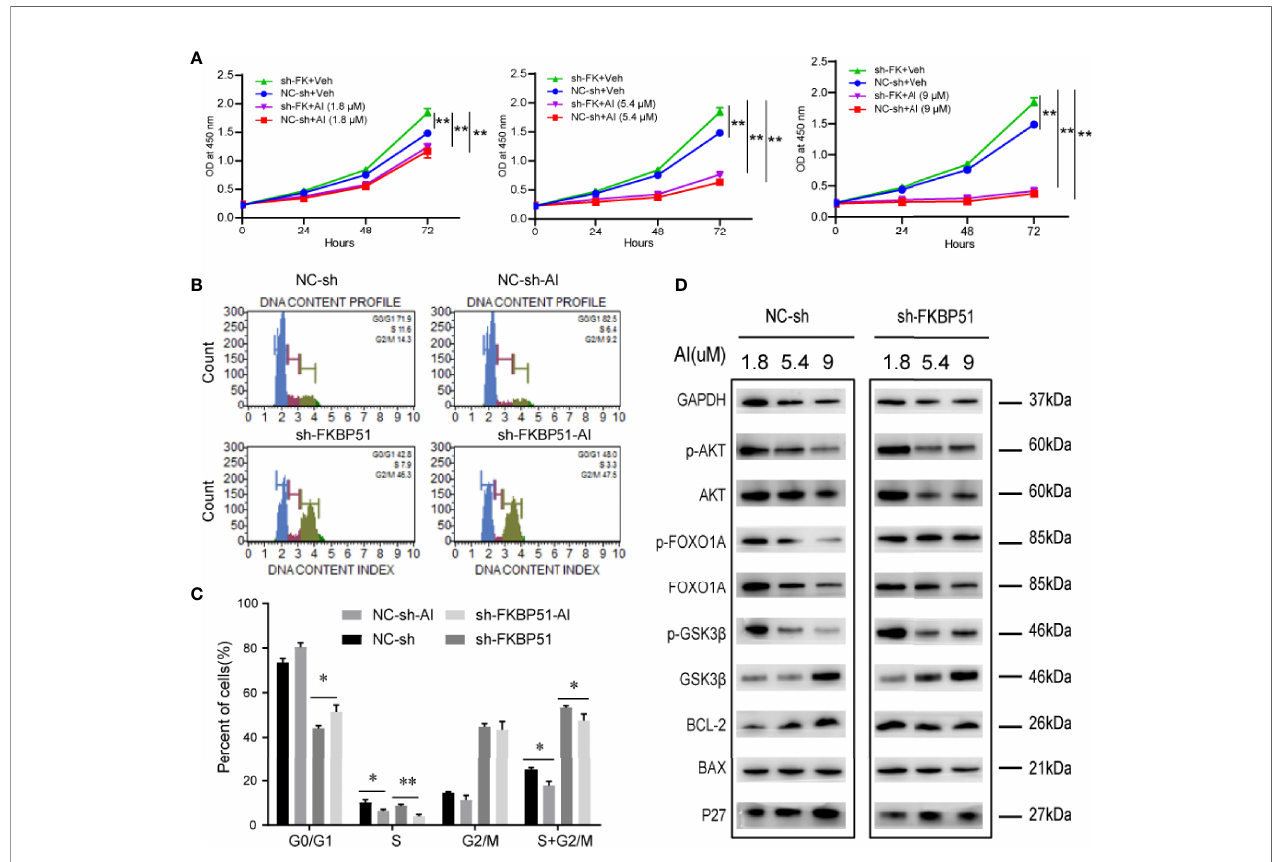
FIGURE 6 | The AKT inhibitor inhibited the proliferation and cycle of AML-M5 cells. (A) FKBP51-knockdown U937 cells and negative control cells were treated with different concentrations of AI and a CCK-8 assay was performed. The absorbance at 450 nm of each group was used to re fl ect cell proliferation. (B, C) The effect of the AKT inhibitor on the cell cycle in FKBP51-knockdown U937 cells and control cells. (D) After treating FKBP51-knockdown U937 cells and negative control cells with AKT inhibitors (1.8, 5.4 and 9 m M) for 24 hours, western blot analysis of total and phosphorylated (Ser473) AKT and AKT downstream targets (p27, BAX, BCL- 2, total and phosphorylated (Ser256) Foxo1, and total and phosphorylated (Ser9) GSK3 b ) was performed. NC-sh, negative control for sh-FKBP51; sh-FKBP51, shRNA-FKBP51; AI, AKT inhibitor. All cells were treated with LPS (1 µg/ml) for 15 min before protein extraction. Each experiment was performed in triplicate. Statistical differences from negative control cells are indicated by asterisks (* for p < 0.05, ** for p <